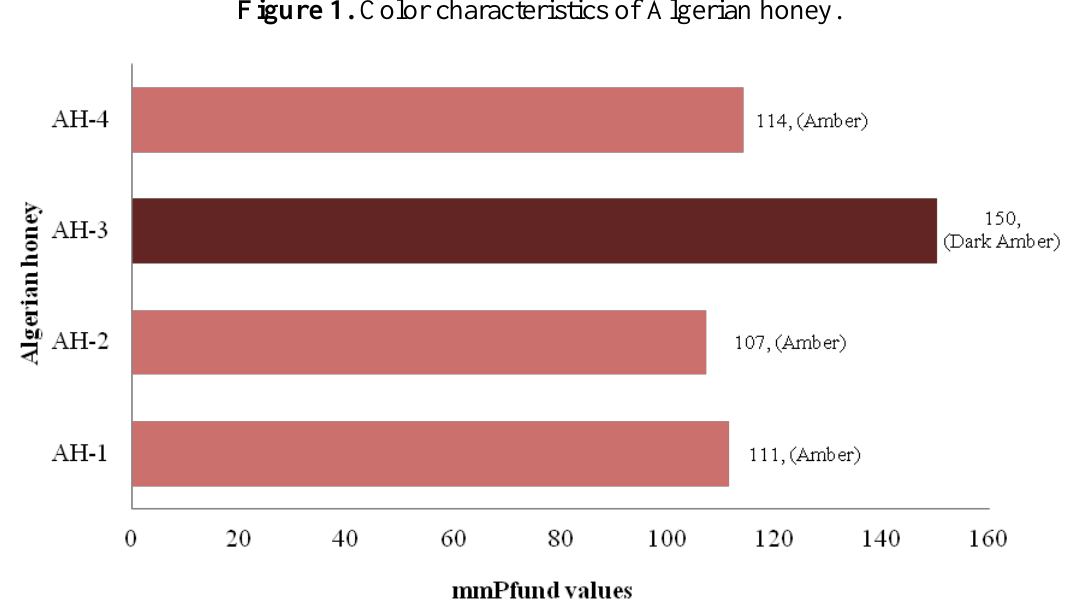
Figure 1. Color characteristics of Algerian